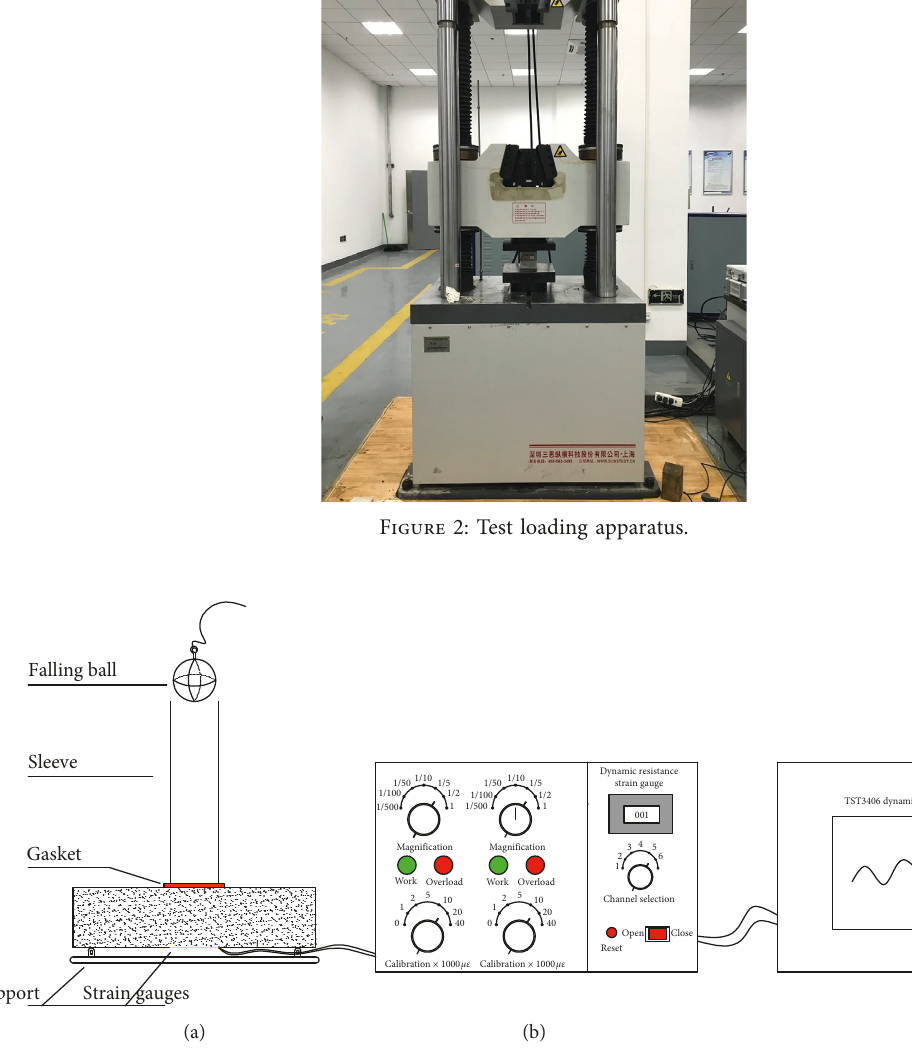
Figure 3: (a) Test device; (b) signal acquisition device; (c) signal analysis